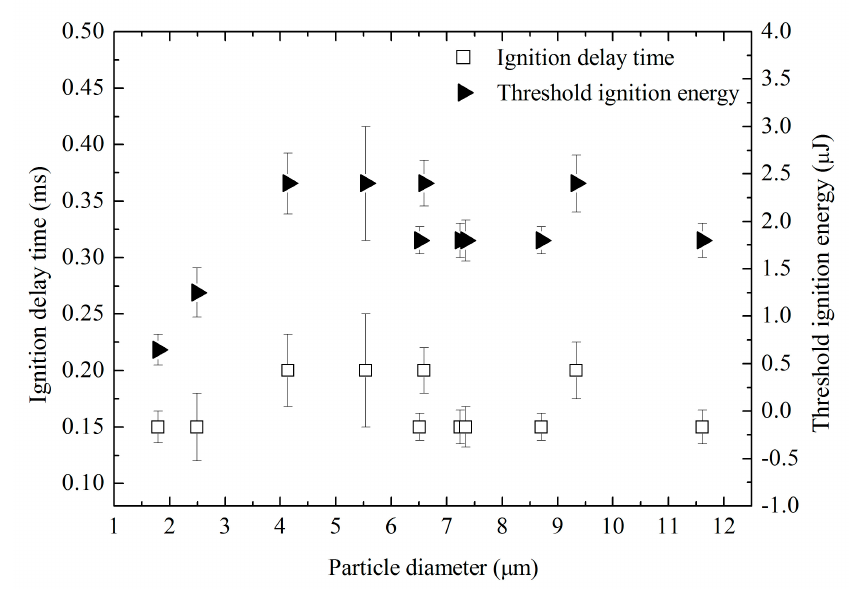
Figure 8. Ignition delay time and threshold ignition energy of graphite at microscale.